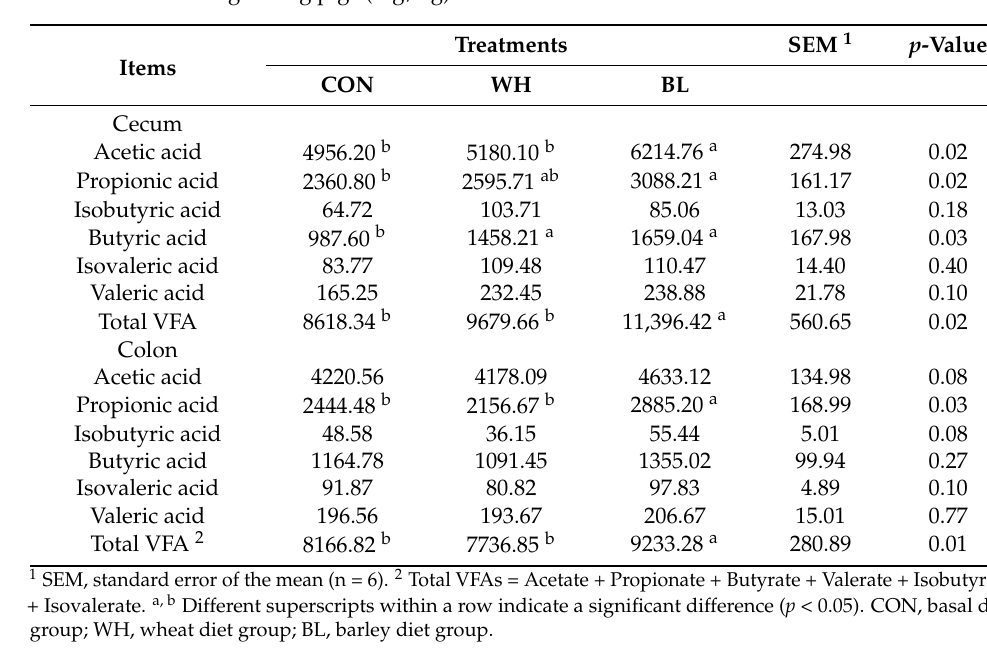
Table 6. Effects of the partial substitution of corn by wheat or barley on volatile fatty acids in the cecum and colon of growing pigs (mg/kg).